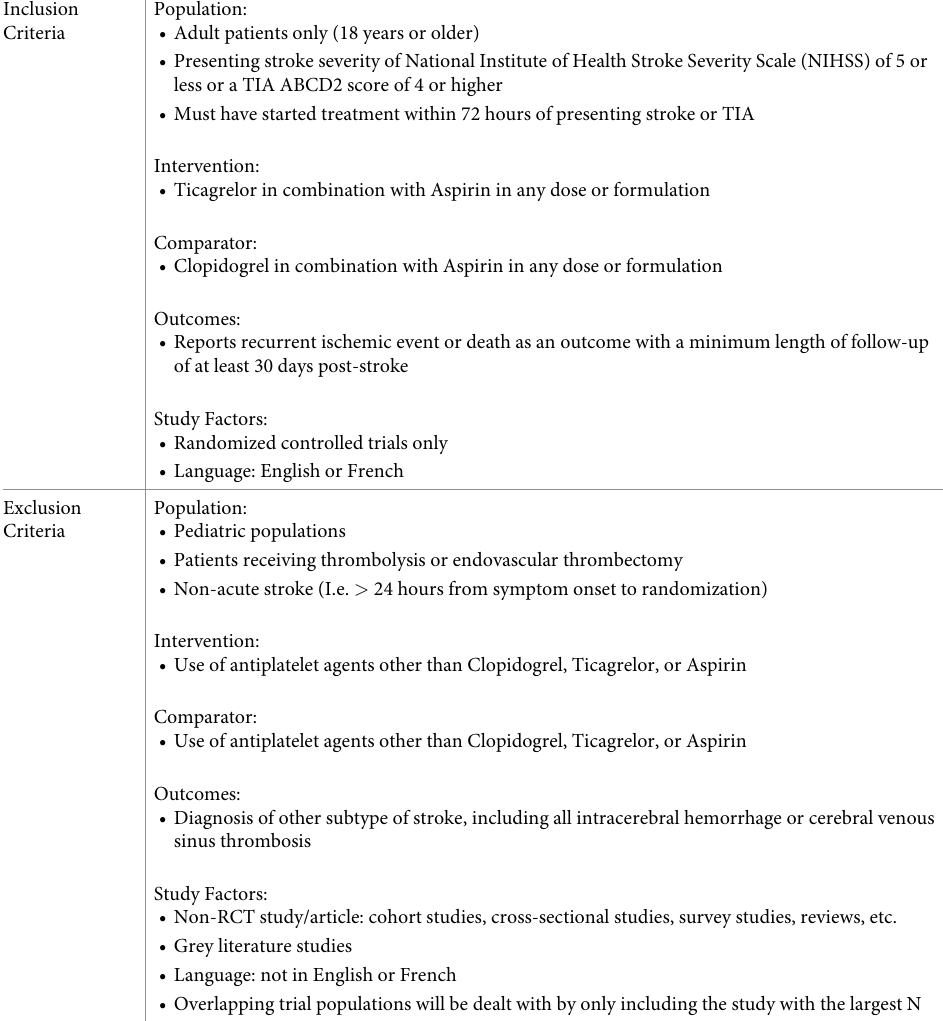
Table 1. Inclusion/exclusion criteria for the planned systematic